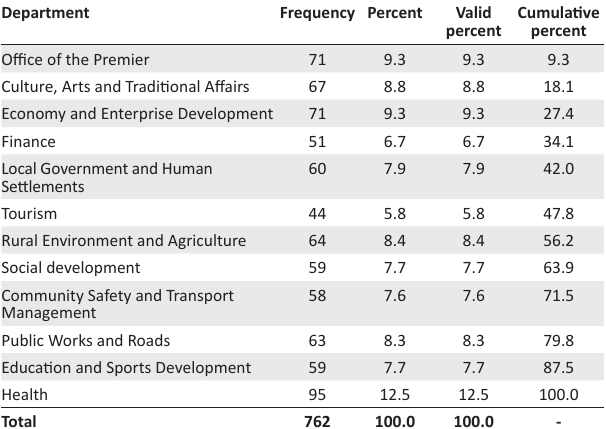
FIGURE 7: Sample size and levels of participants for the focus group interviews which were n = 23. TABLE 3: Quantitative respondents’ response rate per North West provincial administration